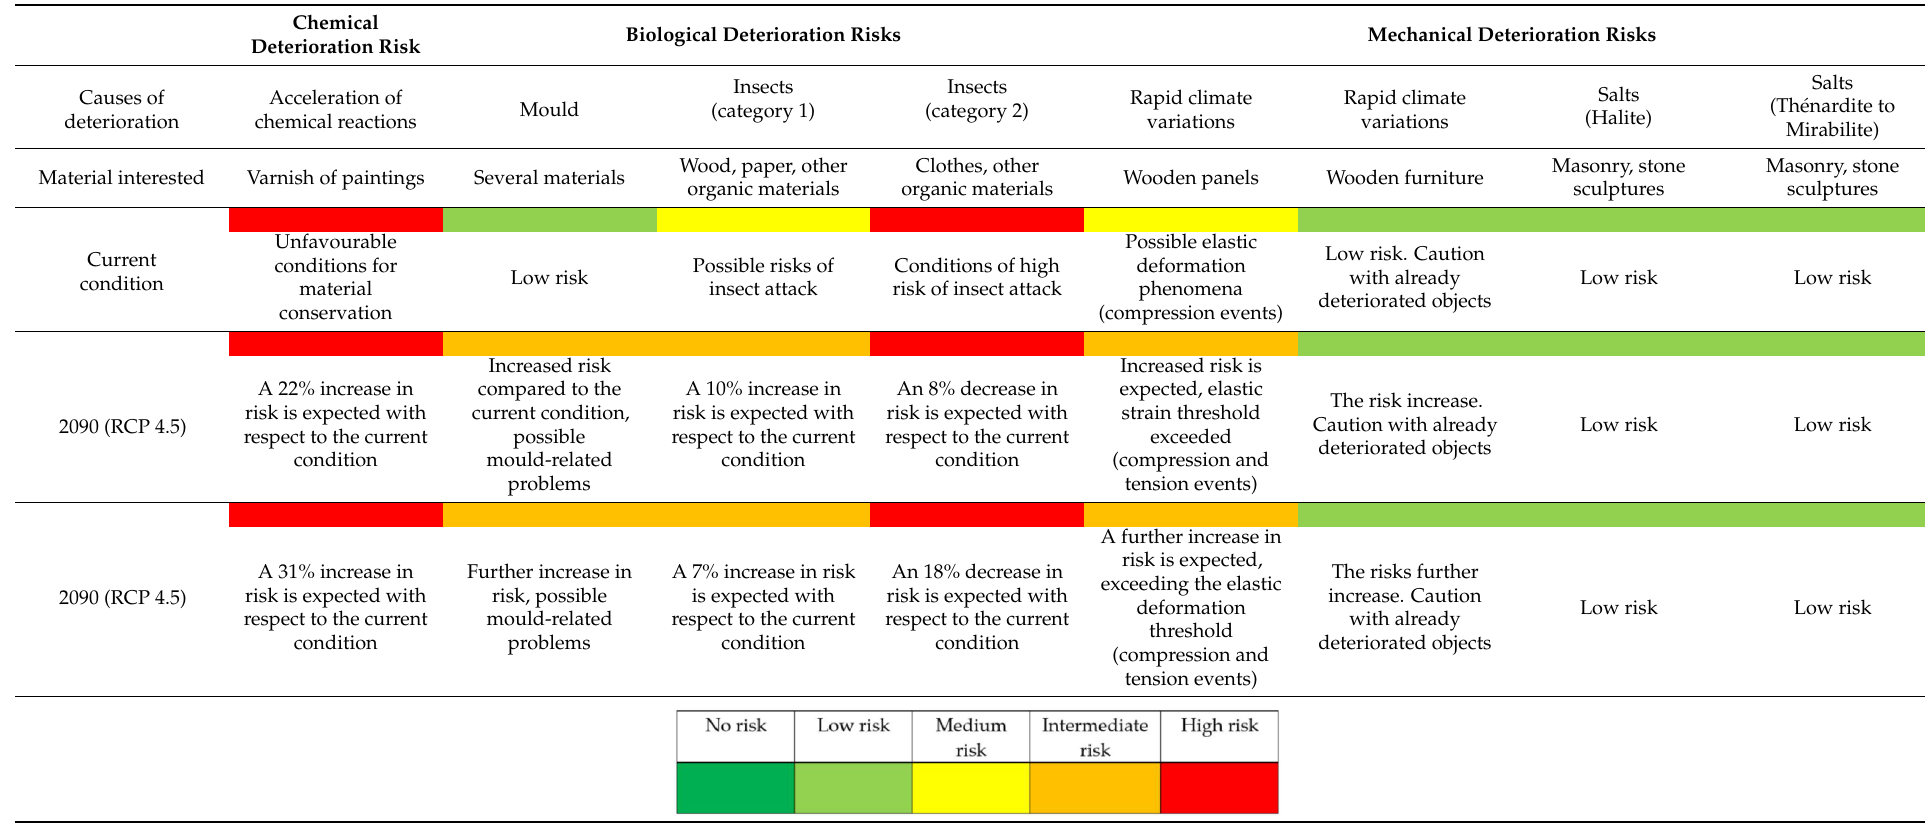
Table A1. Summary of climate change effects on different material deterioration risks.